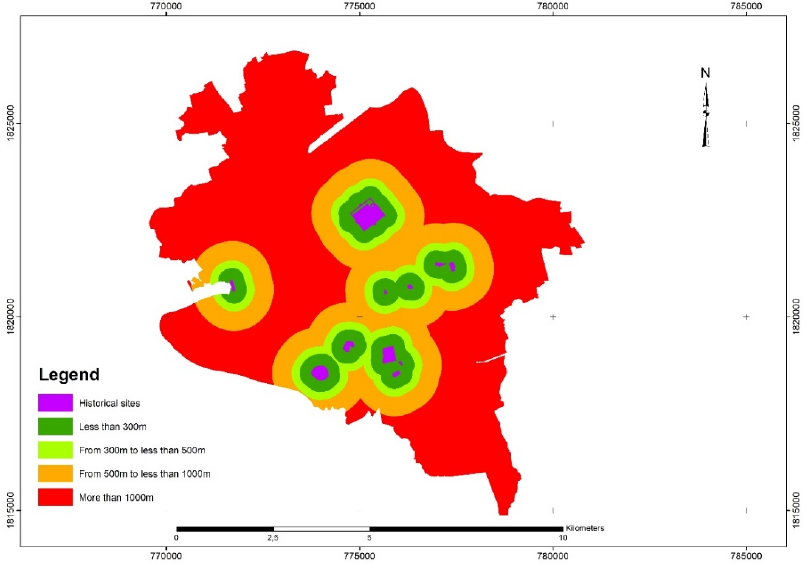
Figure 4. Map of the distance from the historical sites ( sources: authors; Land Use Map in 2020 of Hue City ).